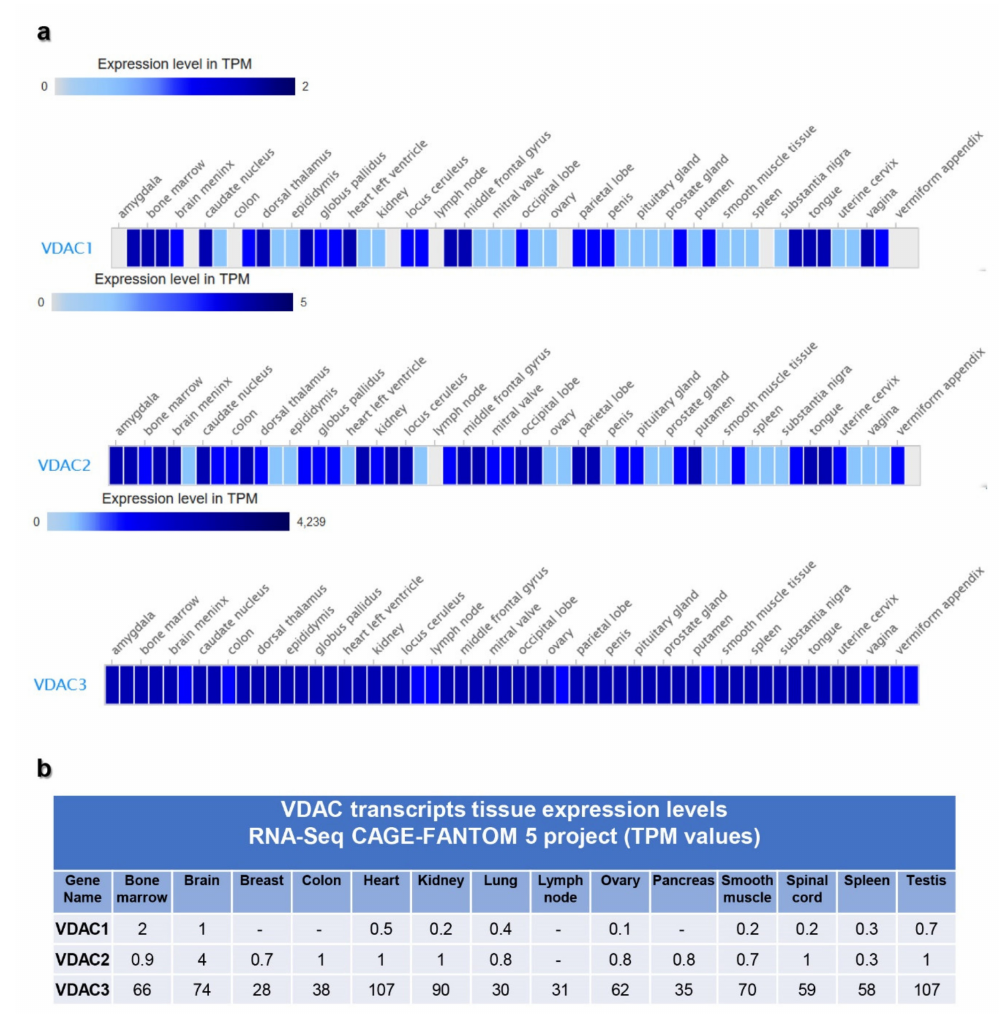
Figure 3. Human VDAC genes expression by RIKEN functional annotation of the mammalian genome 5 (RIKEN FANTOM 5) project. RNA-seq cap analysis gene expression (CAGE) data from the